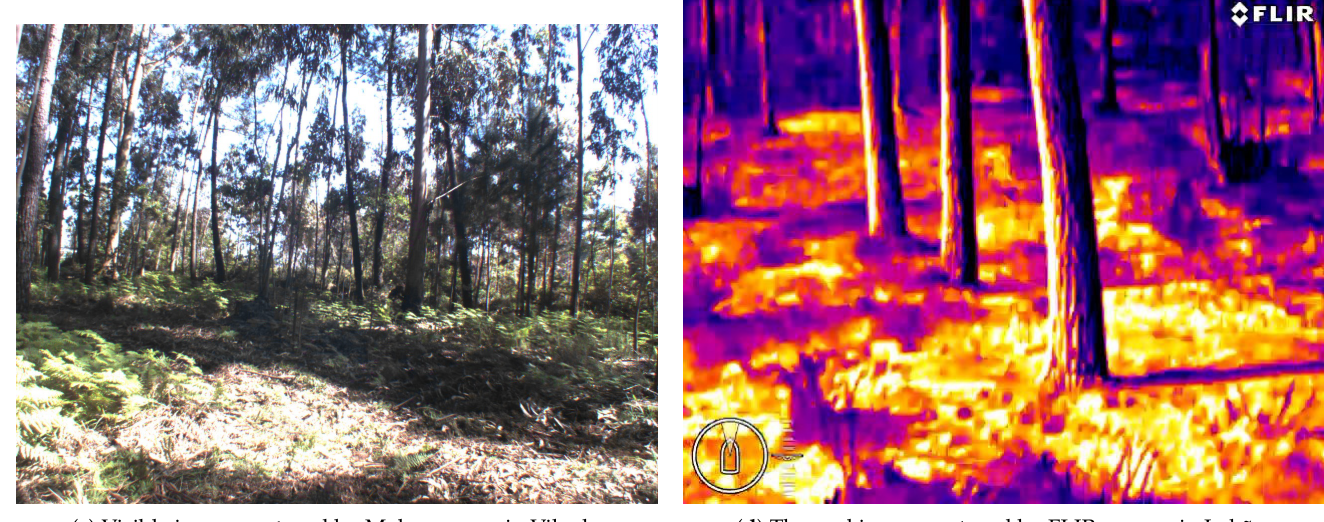
( c ) Visible image captured by Mako camera in Vila do Conde. Figure 2. Illustrative images captured by the four cameras in different locations: ( a ) GoPro, ( b ) ZED, ( c ) Mako, and ( d )